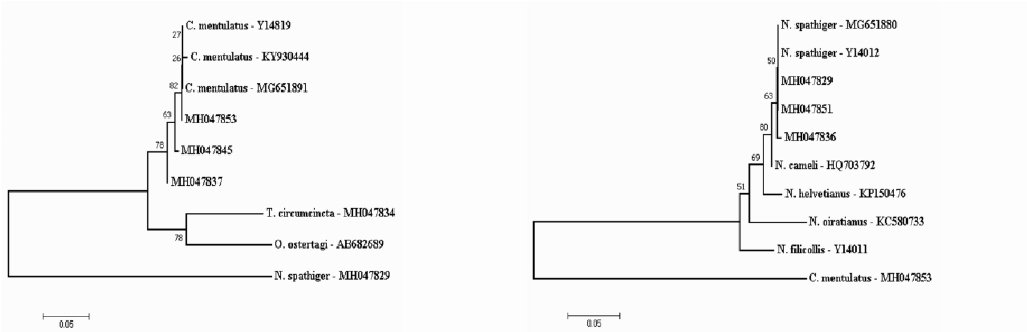
Fig. 1. The phylogenetic relationships of Camelostrongylus mentulatus (left) and Nematodirus spathiger (right) based on ITS- 2 sequences of the rDNA, using the Neighbor-Joining method with the Tamura 3-parameter method. The percentages of repli- cate trees in the bootstrap test (1000 replicates) are shown next to the branches. The analysis involved 9 nucleotide sequences for C. mentulatus (3 from antelopes, one from local domestic sheep and 5 from Genbank) and 10 nucleotide sequences for N. spathiger (3 from antelopes and 7 from Genbank). Evolutionary analyses were conducted in